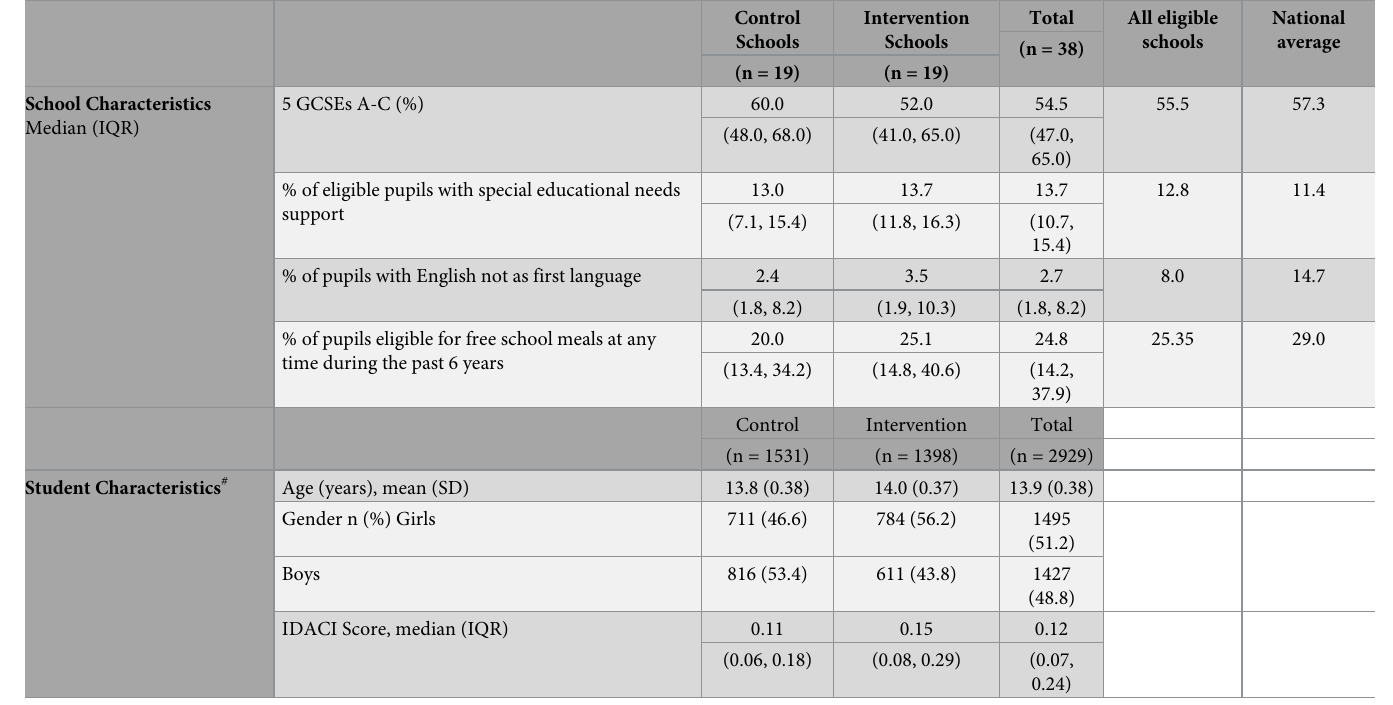
Table 1. Baseline characteristics for intervention and control